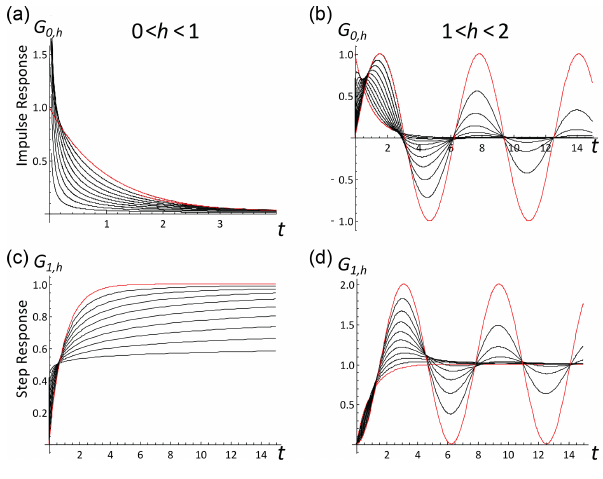
Figure 1. The impulse (a, b) and step response functions (c, d) for the fractional relaxation range ( a, c : 0 < h < 1, and red is h = 1, the exponential), the black curves, bottom to top, are for h = 1 / 10, 2 / 10, ... 9 / 10 and the fractional oscillation range ( b, d : 1 < h < 2, red is the integer values h = 1, c, d is the exponential, and a, b h = 2), and the sine function, the black curves, bottom to top are for h = 11 / 10, 12 / 10, ..., 19 /